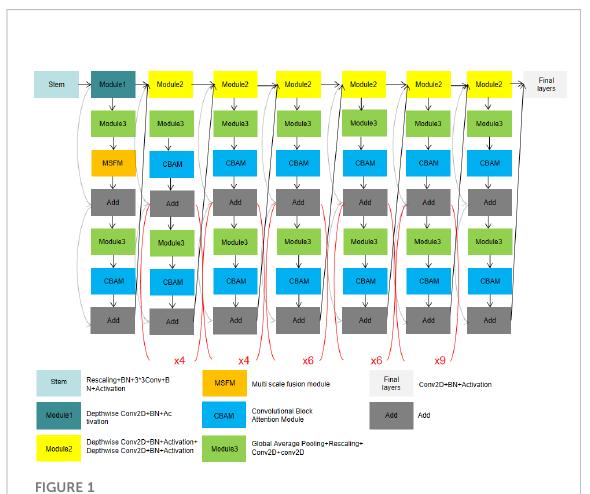
FIGURE 1 Cassava disease classi fi cation model based on multi-scale